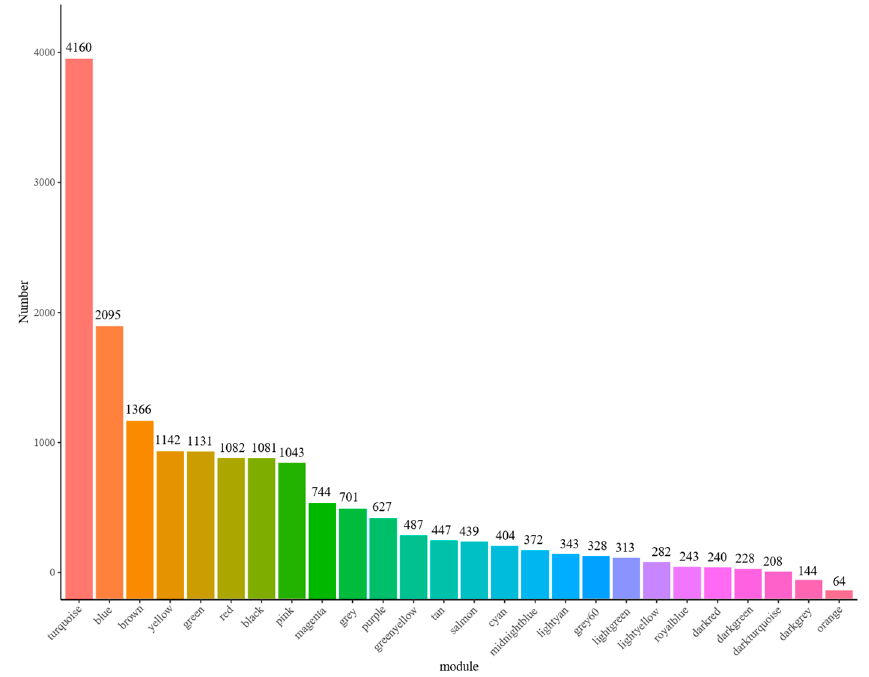
Figure 3. Number distribution of module genes. The abscissa represents the name of the module, and the ordinate represents the number of